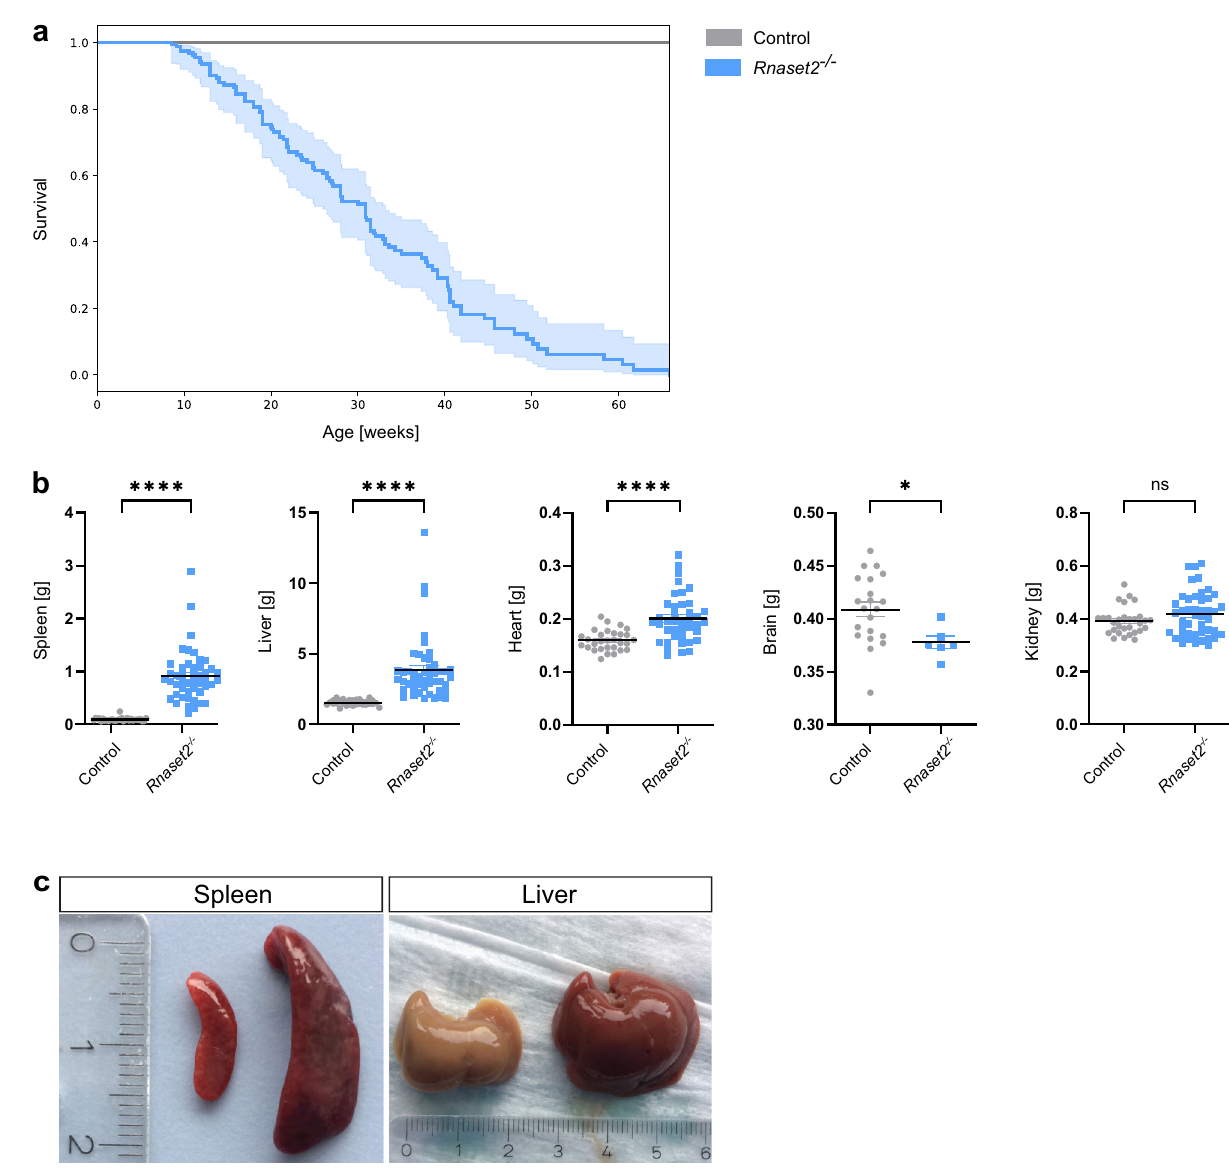
Fig. 1 Survival and organ enlargement of Rnaset2 − / − mice. a Kaplan – Meier blot survival for Rnaset2 − / − (blue, n = 173) and control (gray, n = 102) mice. The median lifetime of Rnaset2 − / − mice is 31 weeks. For the survival curve, a con fi dence interval of 95% is estimated using the exponential Greenwood method. The alpha level was corrected using Bonferroni ’ s method by the number of comparisons (alpha = 0.05/3). b Comparison of organ weights from Rnaset2 − / − mice ( n = 47 for spleen and liver, n = 40 for heart, n = 45 for kidney and n = 6 for brain) and from control mice ( n = 30 for spleen, liver, heart and kidney and n = 21 for brain). Rnaset2 − / − mouse revealed a signi fi cant enlargement of spleen, liver, and heart ( p < 0.0001, respectively). Brain weight was signi fi cantly reduced ( p = 0.0336) and kidney remained unaltered ( p = 0.1205). Data are represented as mean values ± SEM and p values are depicted as **** p < 0.0001, * p < 0.05 and not signi fi cant p ≥ 0.05. c Macroscopy picture of Rnaset2 − / − and control spleen (left) and liver (right) after PBS perfusion in 5-month-old representative mice. Rnaset2 − / − spleen and liver were enlarged in volume and showed a dark red color. Source data are provided as a Source Data fi a score sheet adapted to this particular animal model. The color despite extensive perfusion with phosphate-buffered saline reporting of animals reaching the prede fi ned endpoint criteria (PBS) (Fig. 1c), indicative of extramedullary hematopoiesis. was genotype-blinded. The determined median lifetime of Rna- set2 − / − mice was 31 weeks (Fig. 1a). Rnaset2 − / − mice develop autoin fl ammatory organ disease and Upon autopsy, organ weight analysis of Rnaset2 − / − mice revealed approximately 10-fold enlarged spleens (0.91 ± 0.48 vs. disturbed hematopoiesis . In line with the dark red color 0.09 ± 0.03 g), 2.5-fold enlarged livers (3.84 ± 2.19 vs. 1.55 ± 0.19 g) observed (Fig. 1c), the spleen of Rnaset2 − / − mice showed massive and moderately enlarged hearts (0.20 ± 0.04 vs. 0.16 ± 0.02 g), extramedullary hematopoiesis (Supplementary Fig. 2a – e). Fur- whereas their brains were signi fi cantly decreased in weight thermore, histological evaluations demonstrated an increased (0.38 ± 0.01 vs. 0.41 ± 0.03 g). The kidney weight remained white splenic pulp (Fig. 2a) and predominantly lymphocytic unchanged (Fig. 1b). Notably, liver and spleen had a dark red in fi ltrates in the heart and liver (Fig. 2b, c) of mutant mice.